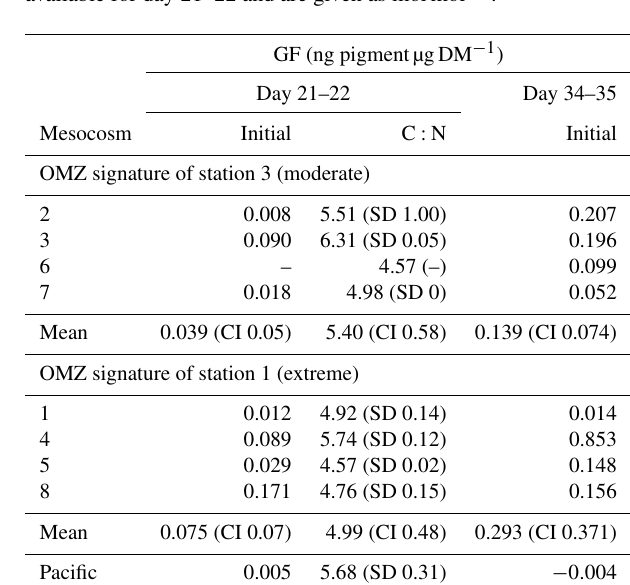
Table 2. Gut fluorescence (GF, ngpigmentµgDM − 1 ) of Para- (day 21–22) and during the night of 31 March to 1 April 2017 (day 34–35), immediately frozen after net retrieval on board to preserve in situ GF (initial gut fluorescence, i.e., T 0min ). Standard devia- tion (SD), 95% confidence intervals (CI), and C : N values are only available for day 21–22 and are given as molmol − 1